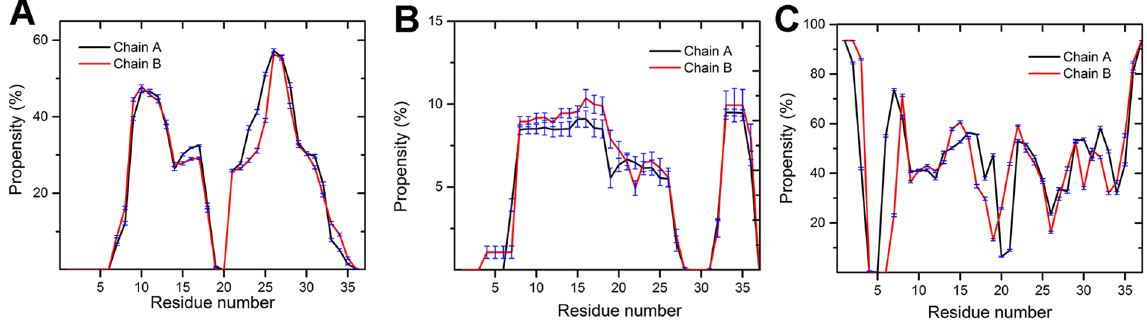
Figure 4. Fraction of secondary structures by residues on each chain. ( A ) β -sheet; ( B ) α -helix; ( C ) random coils. The fractions were reweighted based on Eq. 1. Error bars are calculated from the errors of microstate free energies by following the method described in ref.